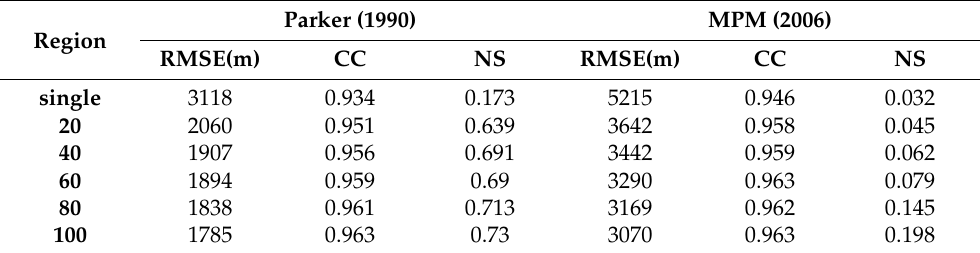
Table 4. Simulation performance obtained from different ensemble size in Dahan River.